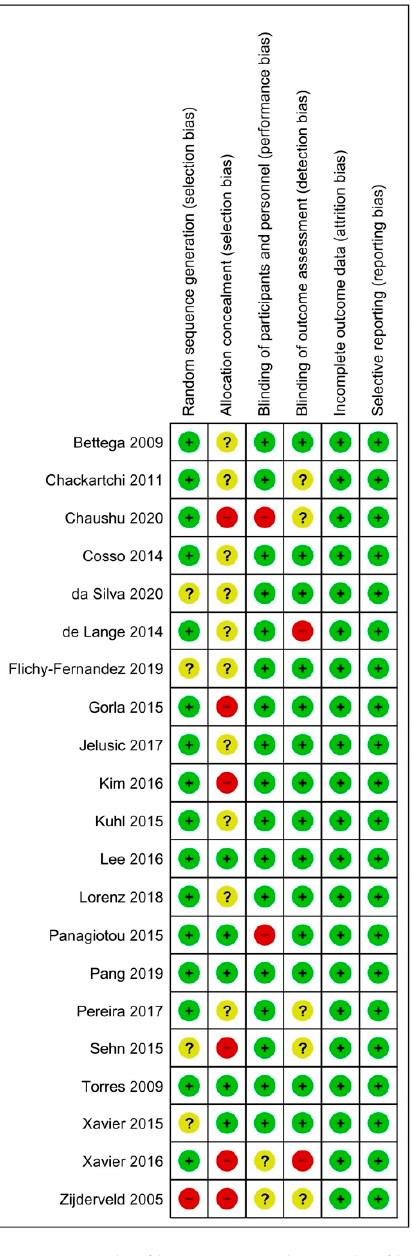
Figure 2. Risk of bias—Green low risk of bias, yellow unclear risk, red high risk of bias.